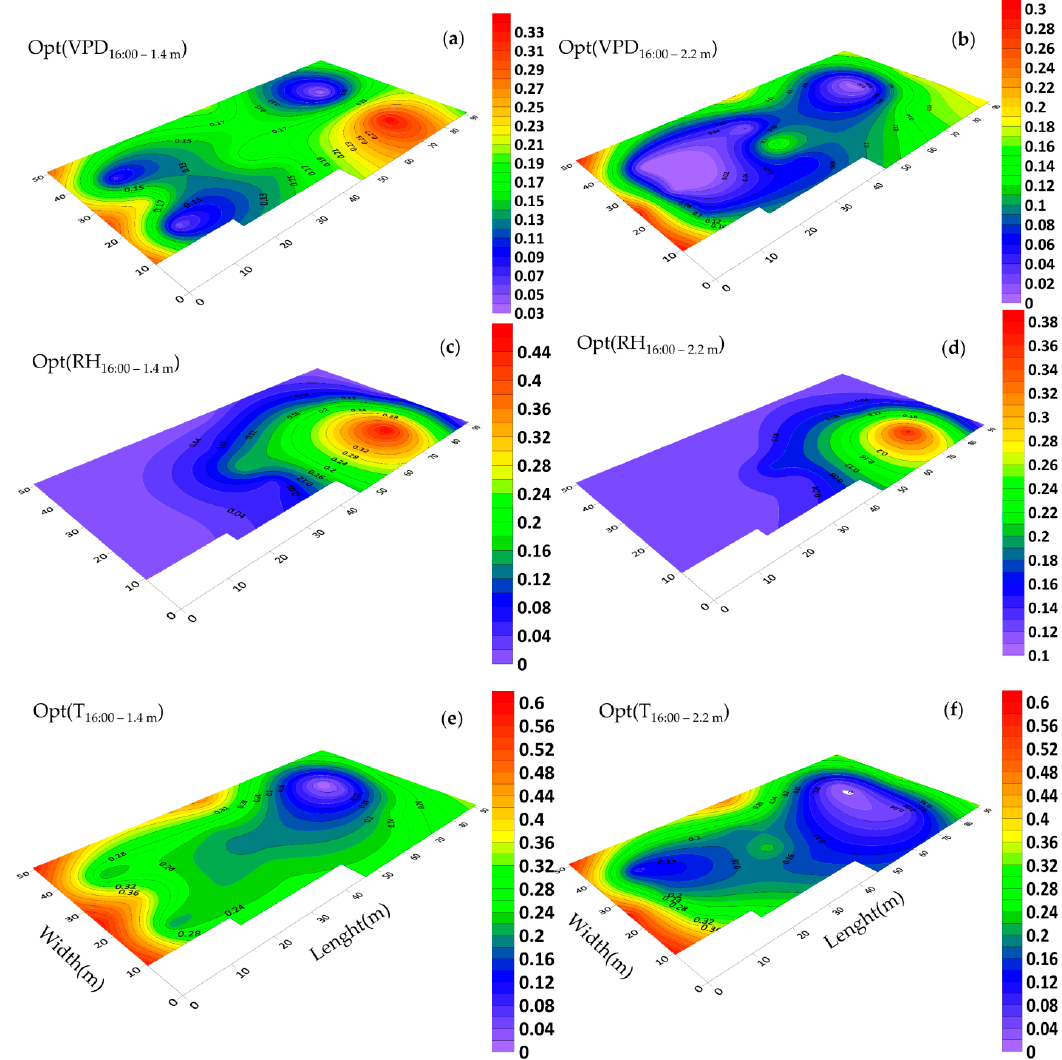
Figure 16. Optimality degrees range and distribution on a horizontal plane at 16:00 in 1.4 m and 2.2 m elevations on 10 June 2018. OptDeg(VPD) at 1.4 m ( a ) and 2.2 m ( b ); OptDeg(RH) at 1.4 m ( c ) and 2.2 m ( d ); and, OptDeg(T) at 1.4 m ( e ) and 2.2 m ( f ).